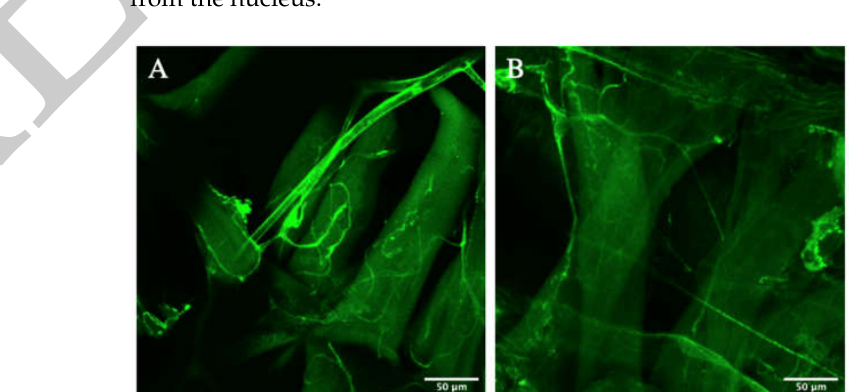
there was a visible decrease in the amount of branching, particularly further away from the nucleus.